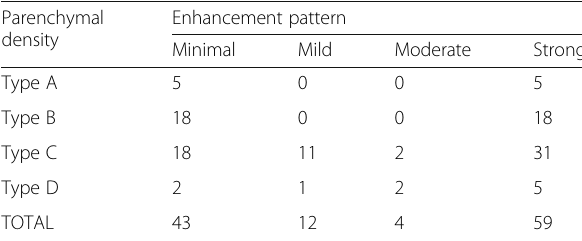
Table 1 The breast parenchyma density and parenchymal enhancement pattern of the patients Parenchymal density